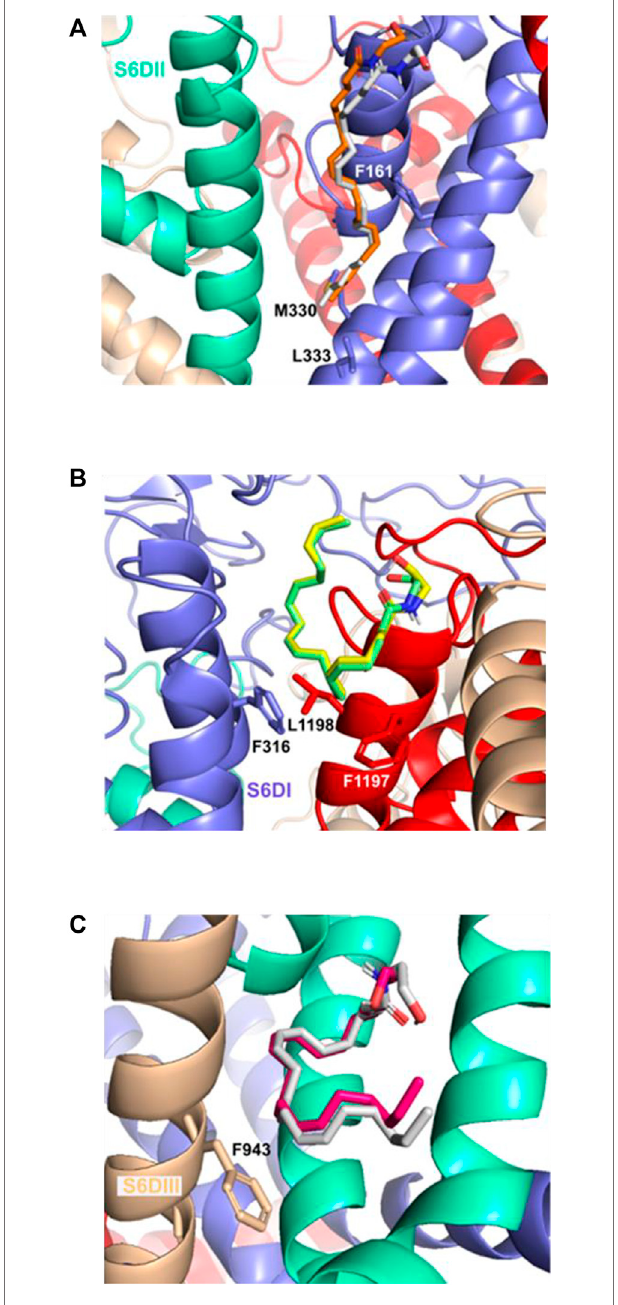
FIGURE6| ImportantresiduesinteractionoftheCa v 3.2channelandthe anandamide conformers: (A) S6DII site and the E closed and E open conformer, (B) S6DI site and the H closed and H open conformers, (C) S6DIII site and the H closed andH open anandamideconformerswith π interactionsmainlywith the F943 residue.